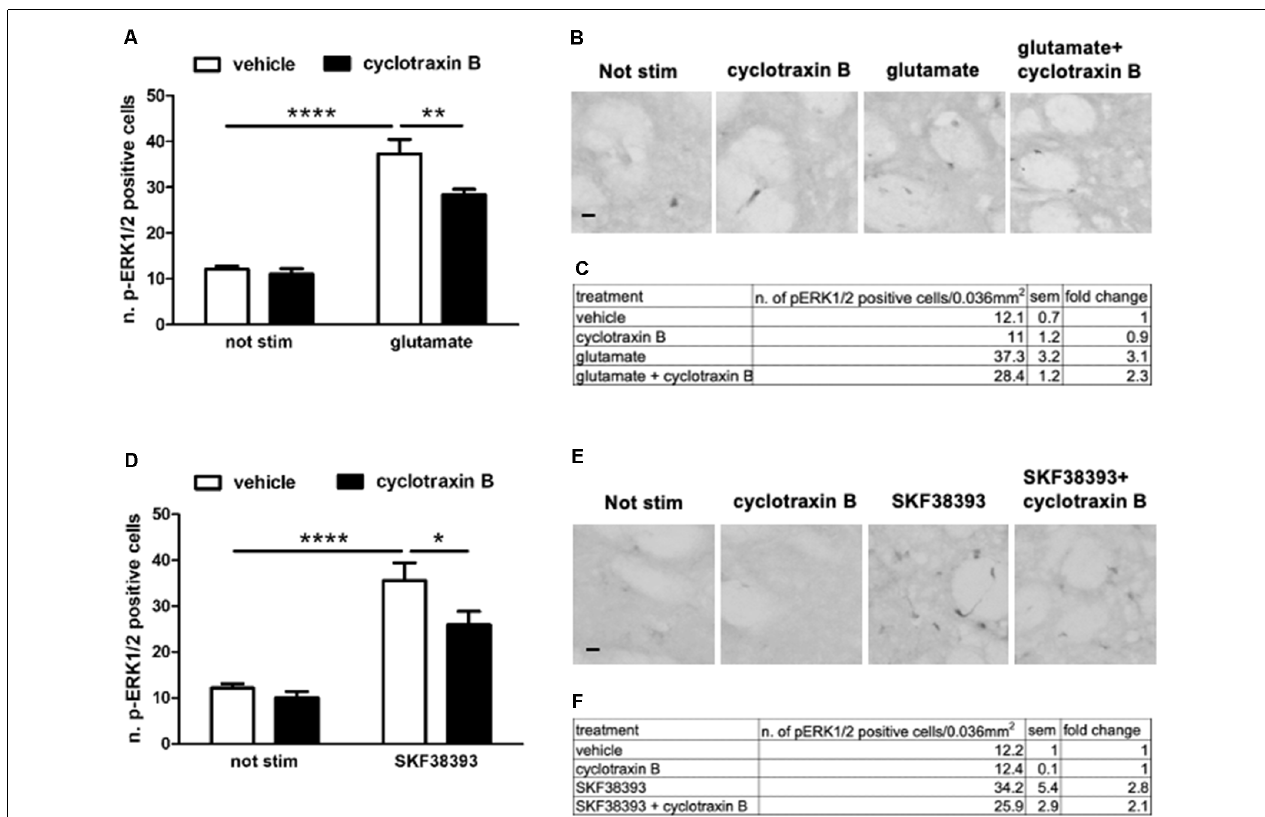
FIGURE 6 | (A,C) Glutamate-induced ERK phosphorylation is significantly reduced by the pre-treatment with TrkB antagonist cyclotraxin B (two-way ANOVA, the effect of glutamate F (1,28) = 135.165, p < 0.0001, the effect of cyclotraxin B F (1,28) = 7.40, p = 0.0111, the effect of interaction F (1,28) = 4.584, p = 0.04. Bonferroni’s post hoc , not stimulated vs. glutamate: **** p < 0.0001, glutamate vs. glutamate + cyclotraxin B: ** p = 0.002). Data are shown as mean ± SEM, n = 8 per group. The values of mean, SEM, and fold change relative to vehicle are shown in panel (C) . (B) Representative pictures of anti-phospho-ERK1/2 immunohistochemistry. Scale bar: 50 µ m. (D,F) Pre-treatment with cyclotraxin B downregulates SKF38393-induced ERK activation (two-way ANOVA, effect of SKF38393 F (1,27) = 55.030, p < 0.0001, effect of cyclotraxin B F (1,27) = 4.947, p = 0.035, effect of interaction F (1,27) = 1.99, p = 0.17. Bonferroni’s post hoc , not stimulated vs. SKF38393 **** p < 0.0001, SKF38393 vs. SKF38393 + cyclotraxin B * p = 0.014). Data are shown as mean ± SEM. The values of mean, SEM, and fold change relative to not stimulated control are shown in panel (F) . Not stimulated: n = 8, cyclotraxin B: n = 7, SKF38393: n = 8, SKF38393 + cyclotraxin B: n = 8. (E) Representative pictures of anti-phospho-ERK1/2 immunohistochemistry. Scale bars: 50 µ